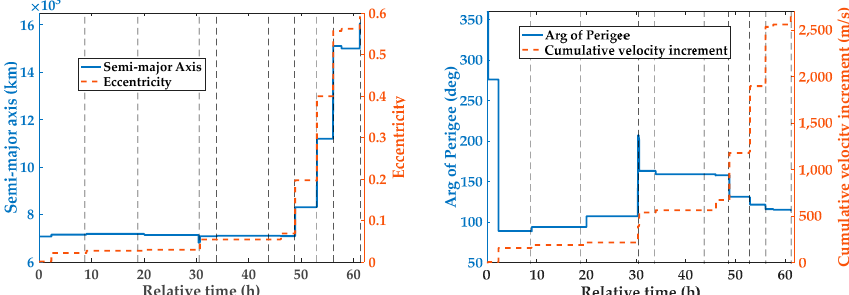
Figure 7. Time-dependent curves of orbit parameters and velocity increment of SS. As shown in Figure 8, the trajectories of the SS are given. Different trajectories represent the trajectories of inspecting different targets. Combined with Figure 7, it can be seen that the semimajor axis and eccentricity of the SS are increasing, but the apsidal line is kept near a region and remains unchanged in the later stage. This kind of phenomenon is an expression of saving propellant.